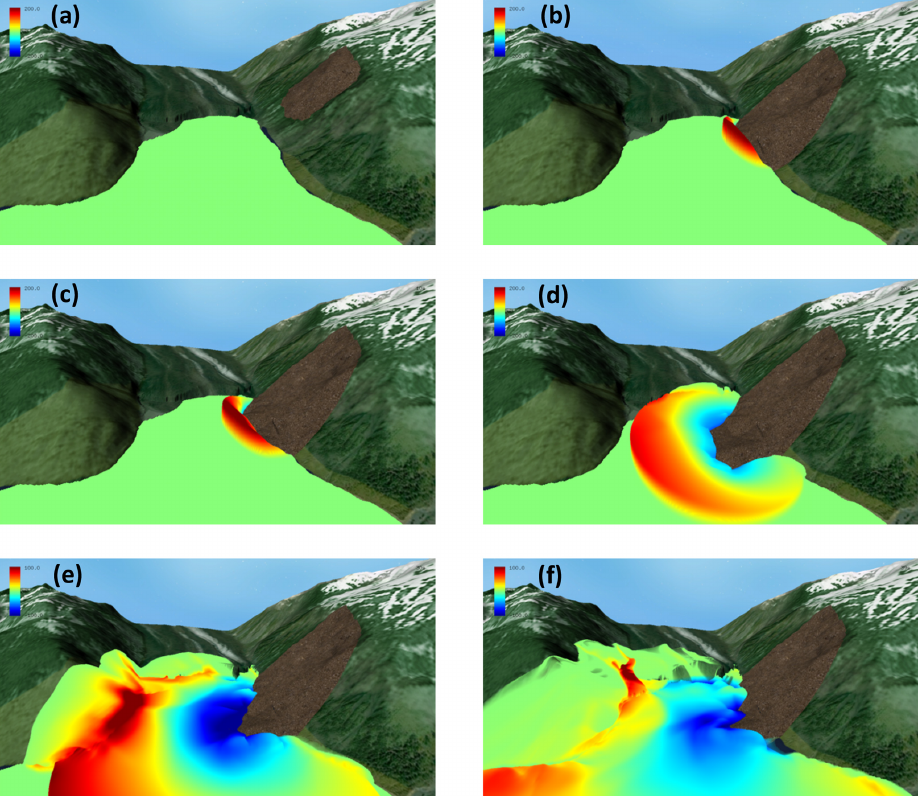
Figure 11. Giant wave generation and initial evolution in Gilbert Inlet. (a) t = 0s; (b) t = 8s. The giant wave reaches 272 . 4m in ampli- tude; (c) t = 10s. Maximum wave amplitude reaches 251 . 1m. (d) t = 20s. Maximum wave amplitude reaches 161 . 5m; (e) t = 30s. The giant wave hits the spur southwest of Gilbert Inlet; (f) t = 39s. Maximum run-up: 523 .